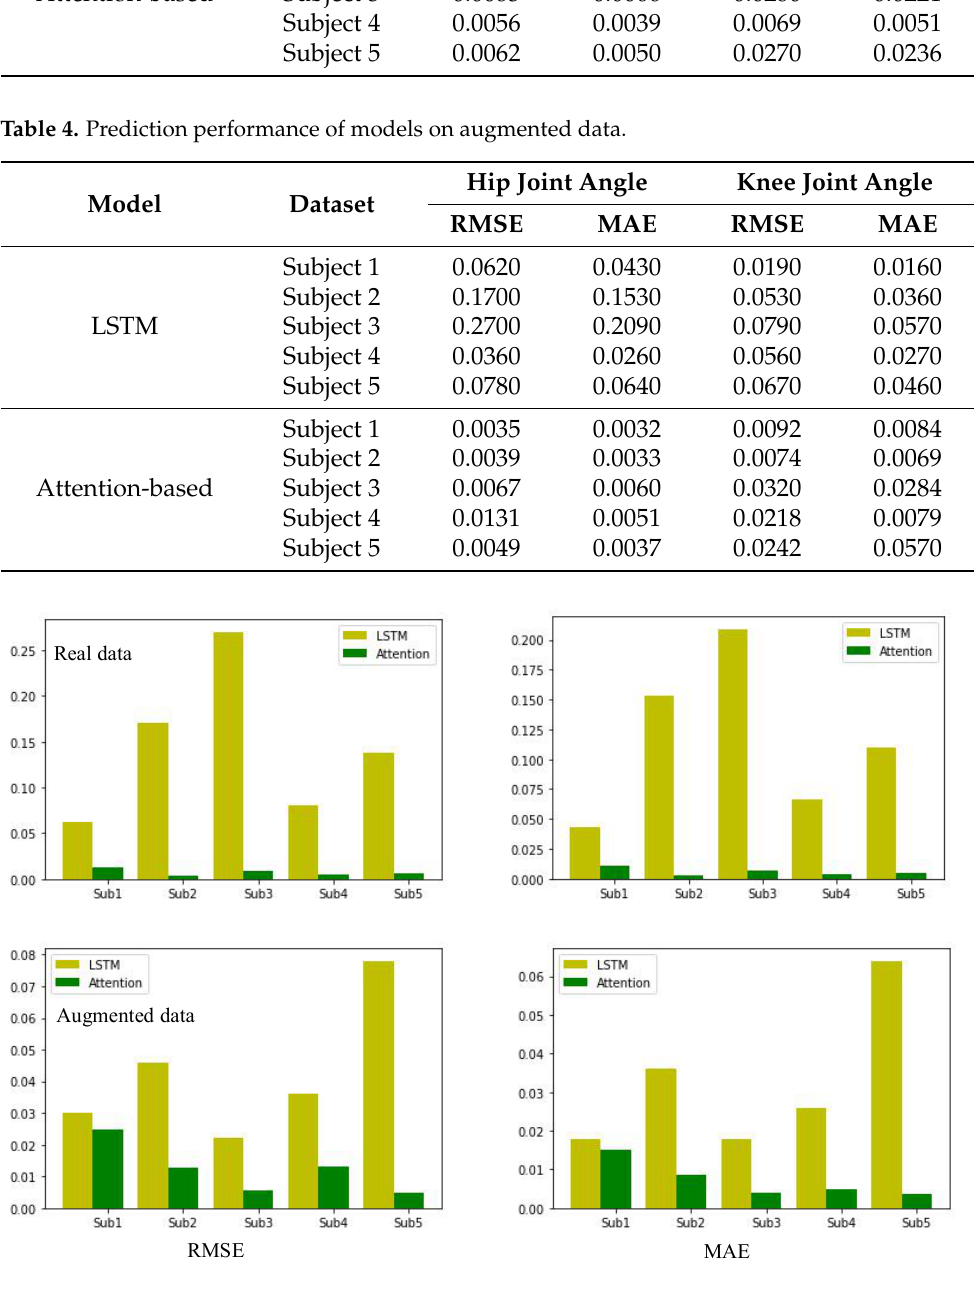
Figure 8. Prediction performance of hip joint angles across all